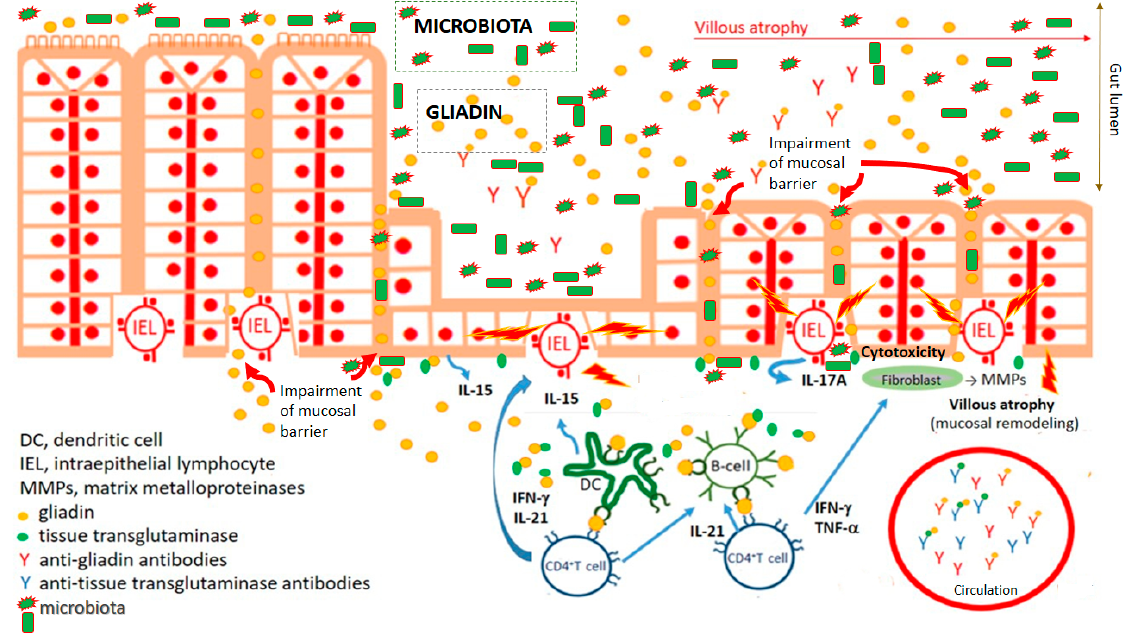
Figure 1. Key characteristics of celiac disease pathogenesis. Impairment of mucosal barrier of small intestine and penetration of food antigens, including wheat gliadin. Gliadin fragments are deamidated by tissue transglutaminase. Deamidated gliadin fragments stimulate (boosted by adjuvant properties of microbiota) innate immune cells, counting professional antigen presenting cells (dendritic cells), which present deamidated gliadin peptides by CD4 + T cells. Polarization of CD4 + T lymphocyte development to Th1 cytokine profile leads to activation (intraepithelial) lymphocytes and damaging of enterocytes. Activation of fibrocytes by Th1 cytokines trigger releasing of matrix metalloproteinases mediating pathological remodeling of small gut mucosa of celiac patients. Simultaneously, antibodies against gliadin and autoantibodies against tissue transglutaminase are developed.